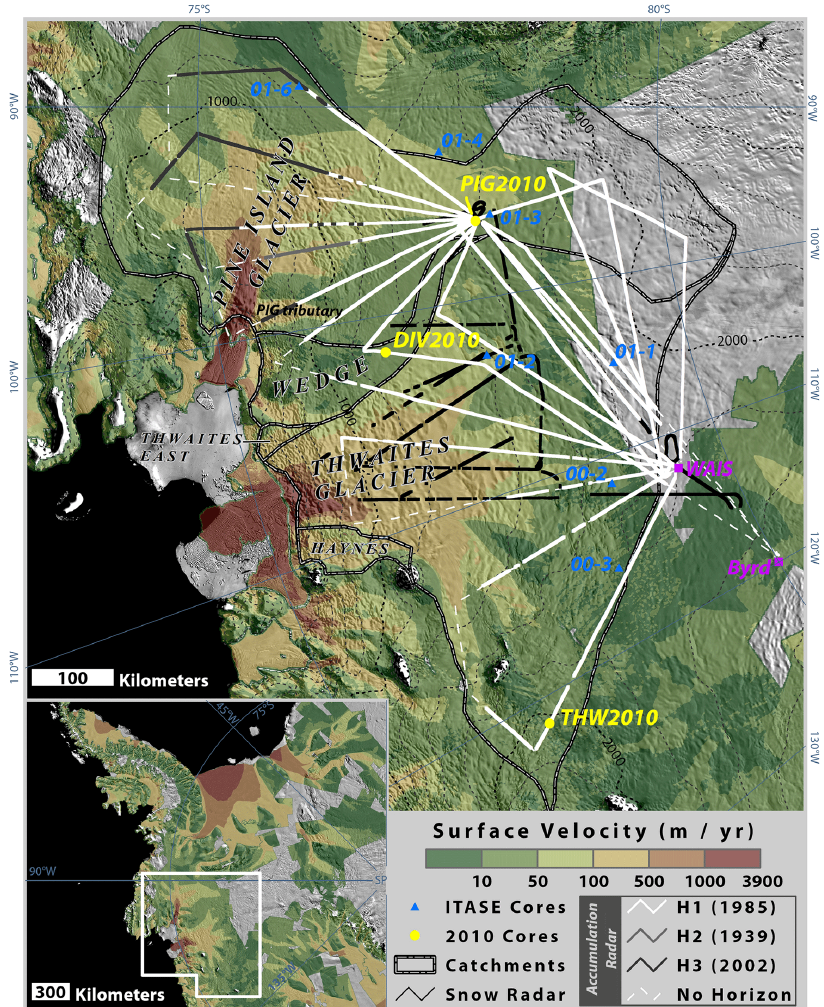
Figure 1. The Amundsen Sea coast glaciers and locations of the radar flight surveys. Here, the MODIS mosaic is overlaid transparently by measured ice velocities from Joughin et al. (2010) and elevation contours (200m intervals). The catchments are outlined and labeled. The complete accumulation radar survey consists of the white and grey lines. A dashed white line indicates no horizon was mapped, a solid white line indicates H1 was mapped, and light (dark) grey indicates that H2 (H3) was mapped. The solid black lines show where snow radar accumulation measurements were taken from Medley et al. (2013). The three 2010 ice cores are labeled and indicated by a yellow circles. The ITASE cores are displayed as blue triangles, and the WAIS divide and Byrd camps are labeled and indicated by light purple squares. With the exception of Byrd, density measurements from all the ice-core sites were used to create a regional density profile in Fig. 3. The inset map shows the location of our study